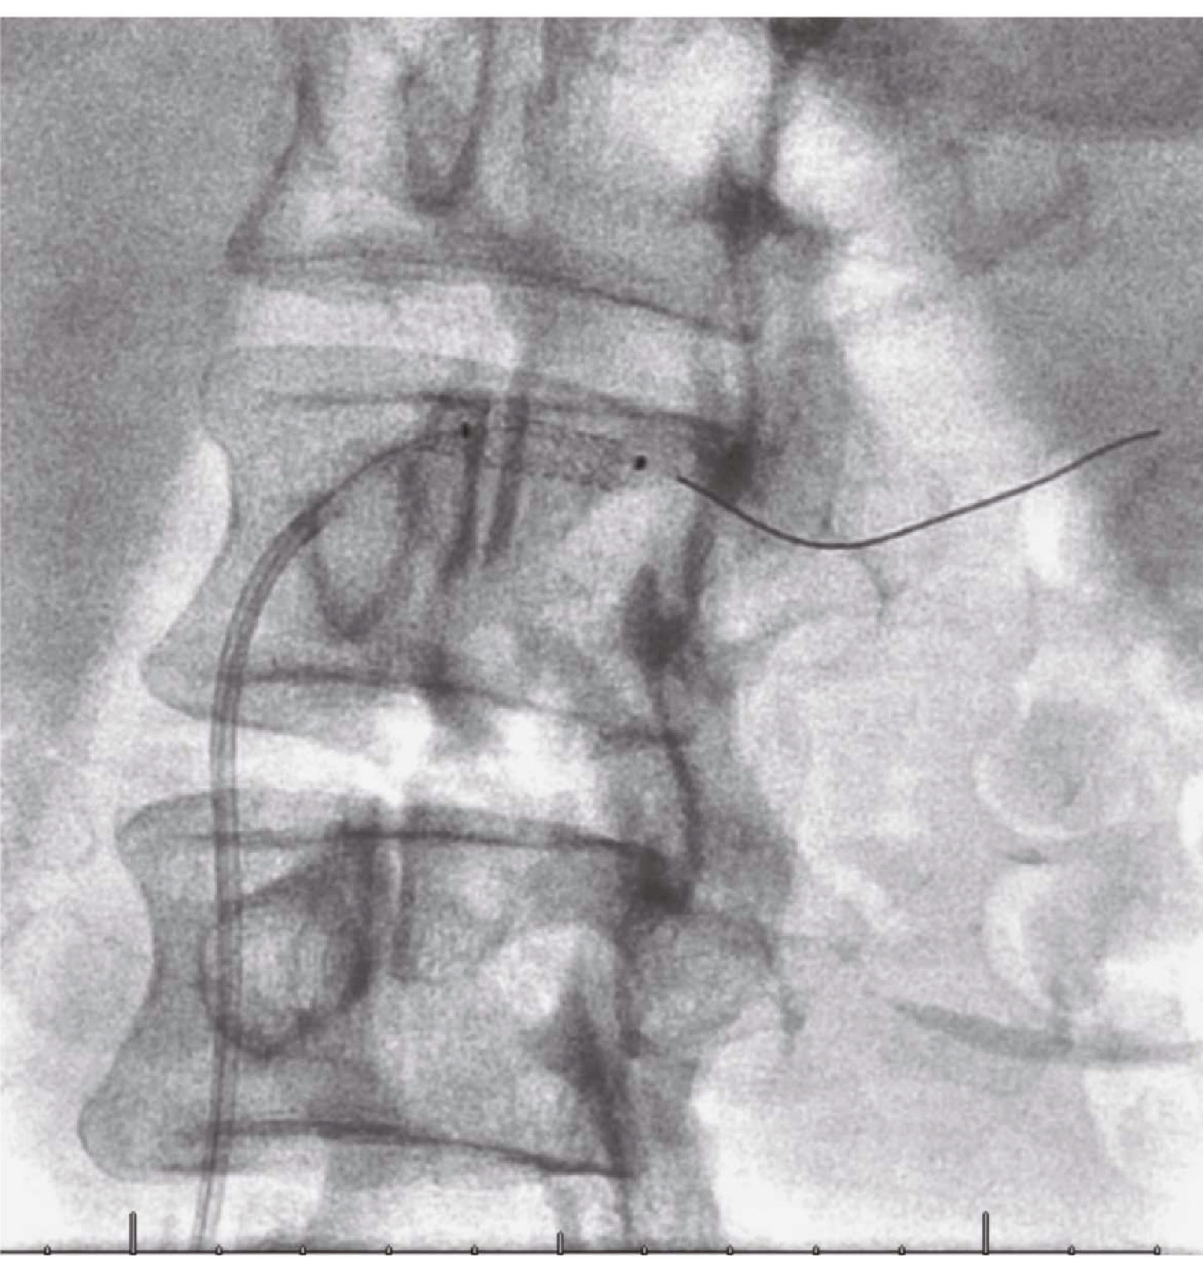
Figure 10: The angiojet thrombectomy was done inside the